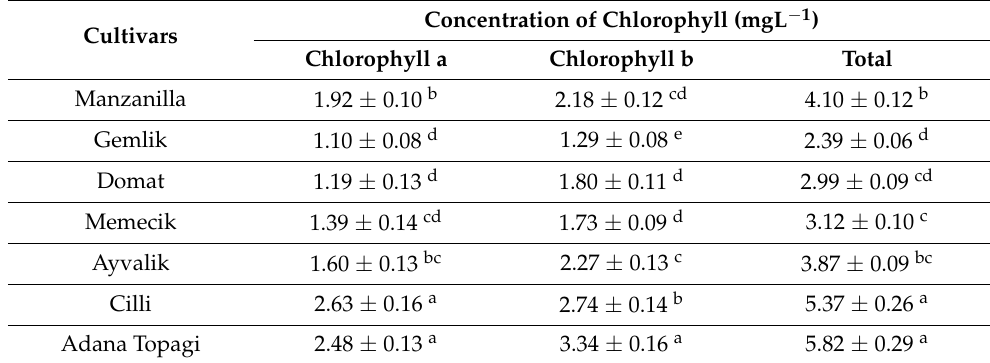
Table 2. Chlorophyll a, chlorophyll b and total chlorophyll content of cultivars ( n =